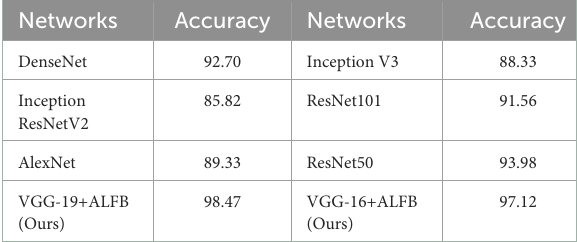
TABLE 4 Comparison of the proposed architectures with adding layer and freezing blocks (ALFB) in VGG16 and VGG-19, with the existing state-of-the-art architectures in terms of accuracy.